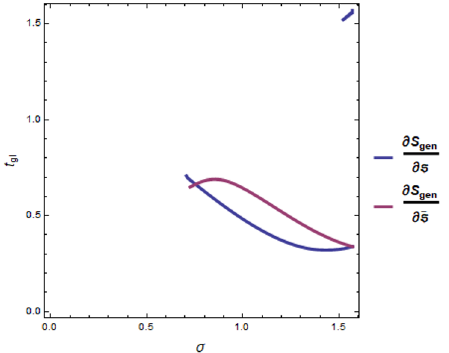
Figure 14. The position of all behind-shock QESs. The zeroes of both equations are plotted in the region behind the shock and spacelike to the boundary point s = π − ¯ s = 2 tan − 1 ζ u . They intersect at the symmetric surface σ = π/ 2 , and also at a point that is right behind the shock and nearly null-separated from the boundary point. The parameters have the values k = . 1 , ζ u = . 78